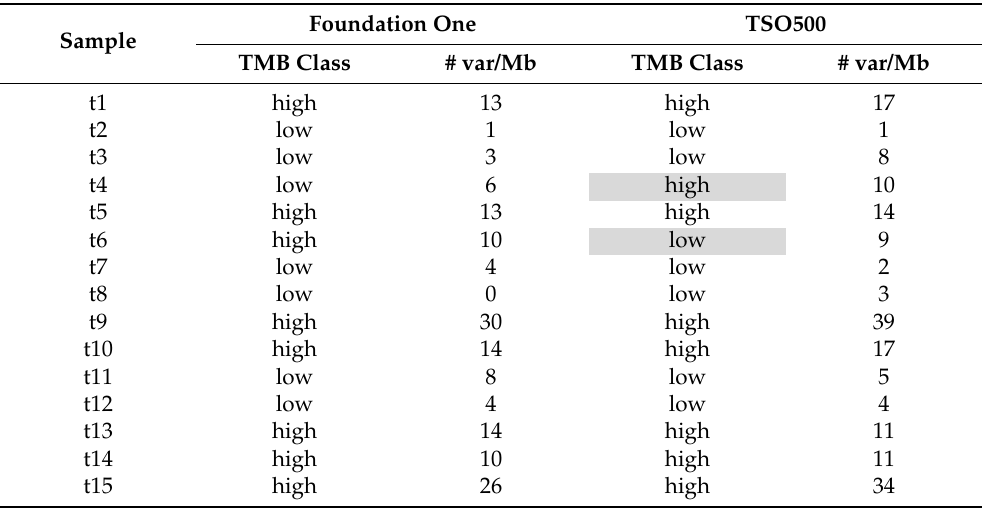
Table 3. Analytical performance of TMB analysis with the TSO500 assay compared to the Founda- tionOne